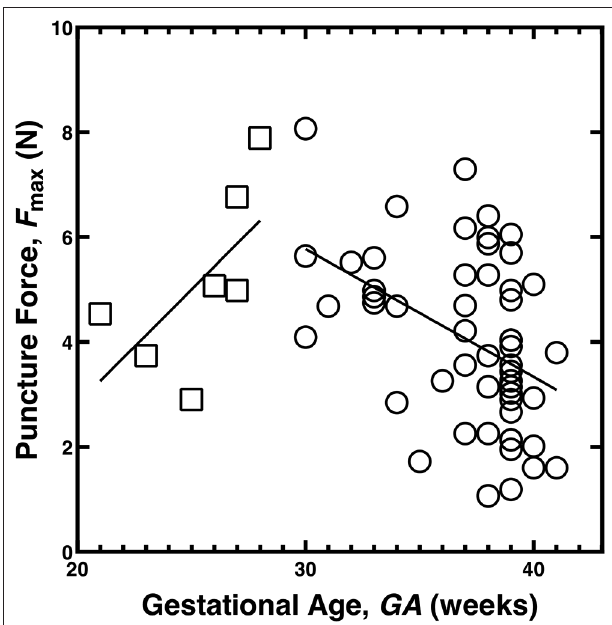
FIGURE 1 | Puncture force for the chorioamnion membrane as a function of gestational age, data from the studies (Oyen et al., 2004, 2006). The data have been split into two groups and fit with linear trend lines, GA ≤ 29 weeks (open squares) and GA ≥ 30 weeks (open circles).